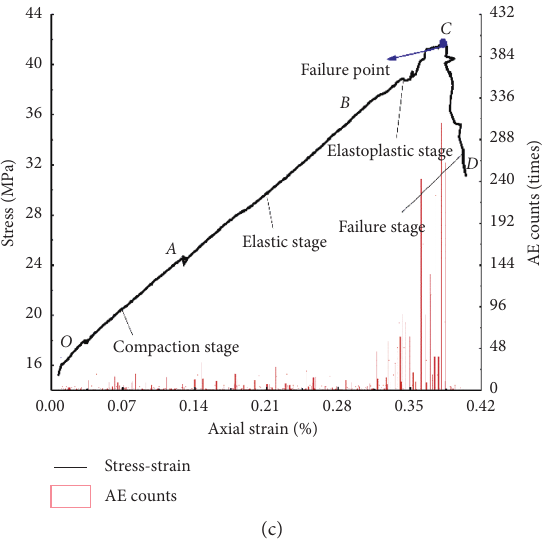
Figure 6: Corresponding curves of AE counts under different strain rates. (a) 0.005%/min strain rate. (b) 0.02%/min strain rate. (c) 0.03%/ min strain rate.